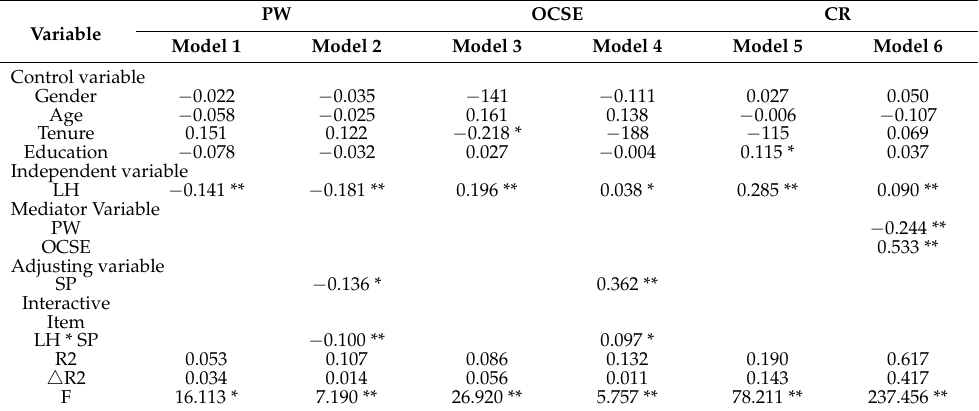
Table 3. Influence of leader humor on perceived workload, occupational coping self-efficacy, and creativity (N =